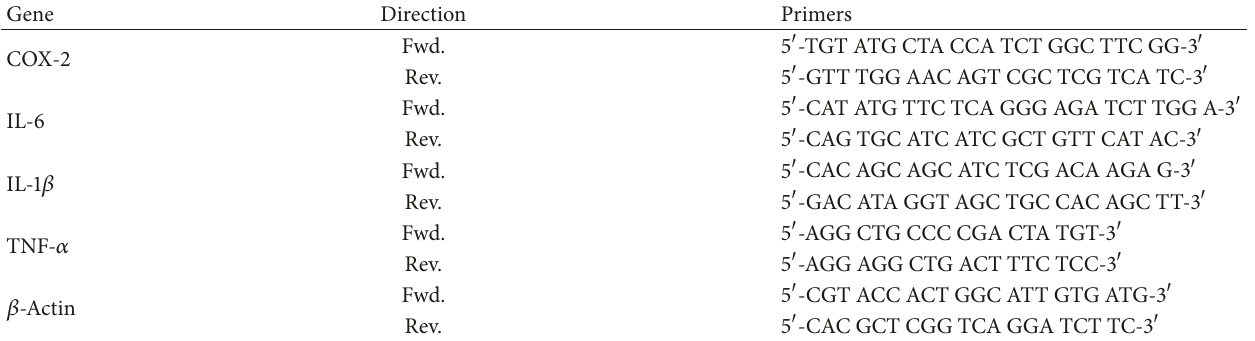
Table 1: Real-time polymerase chain reaction